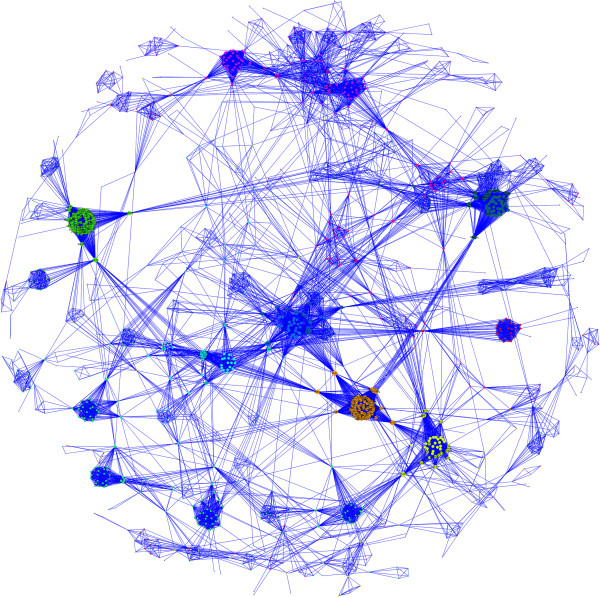
OMIM Gene Network. Genes are colored based on their cluster membership, and node size is proportional to a gene’s propensity. This view was achieved with a spring-embedded layout in Cytoscape using the number of edges between two genes as weights. Note that CPBA based clustering identifies modules of highly interconnected nodes.